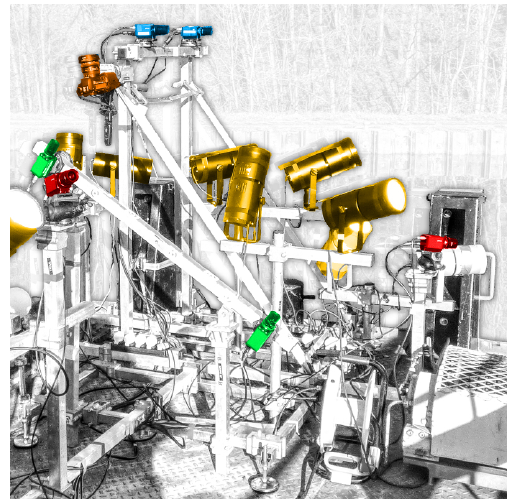
Figure 2. Image acquisition system with the first stereo rig in green, the second stereo-rig in blue, the oblique cameras in red, the fish-eye camera in orange, and the lighting system in